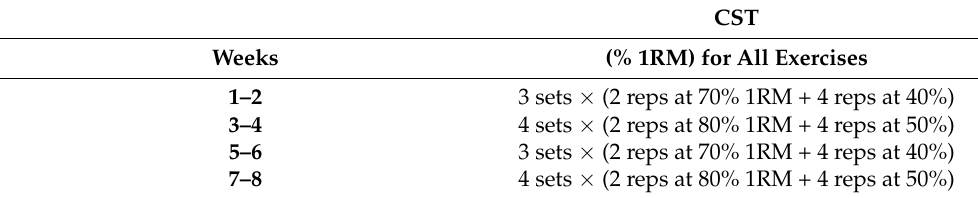
Table 1. Design of the 8-week contrast strength training program.